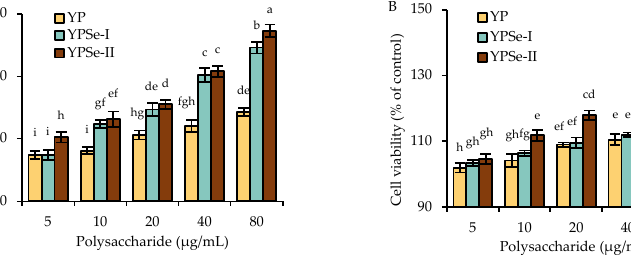
Figure 1. Cell viability (%) of the IEC-6 cell exposed to YP, YPSe-I, and YPSe-II for 12 ( A ) and 24 ( B ) h or exposed to Na 2 SeO 3 ( C ). Different lowercase letters above the columns denote a significant difference in the one-way ANOVA means ( p < 0.05).